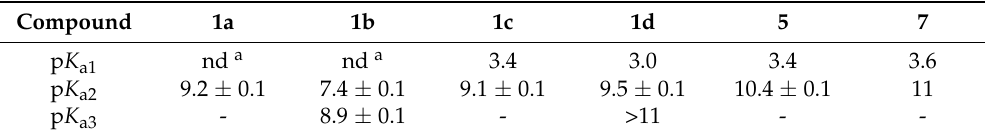
Table 5. p K a values determined for the isonicotinoylhydrazones.